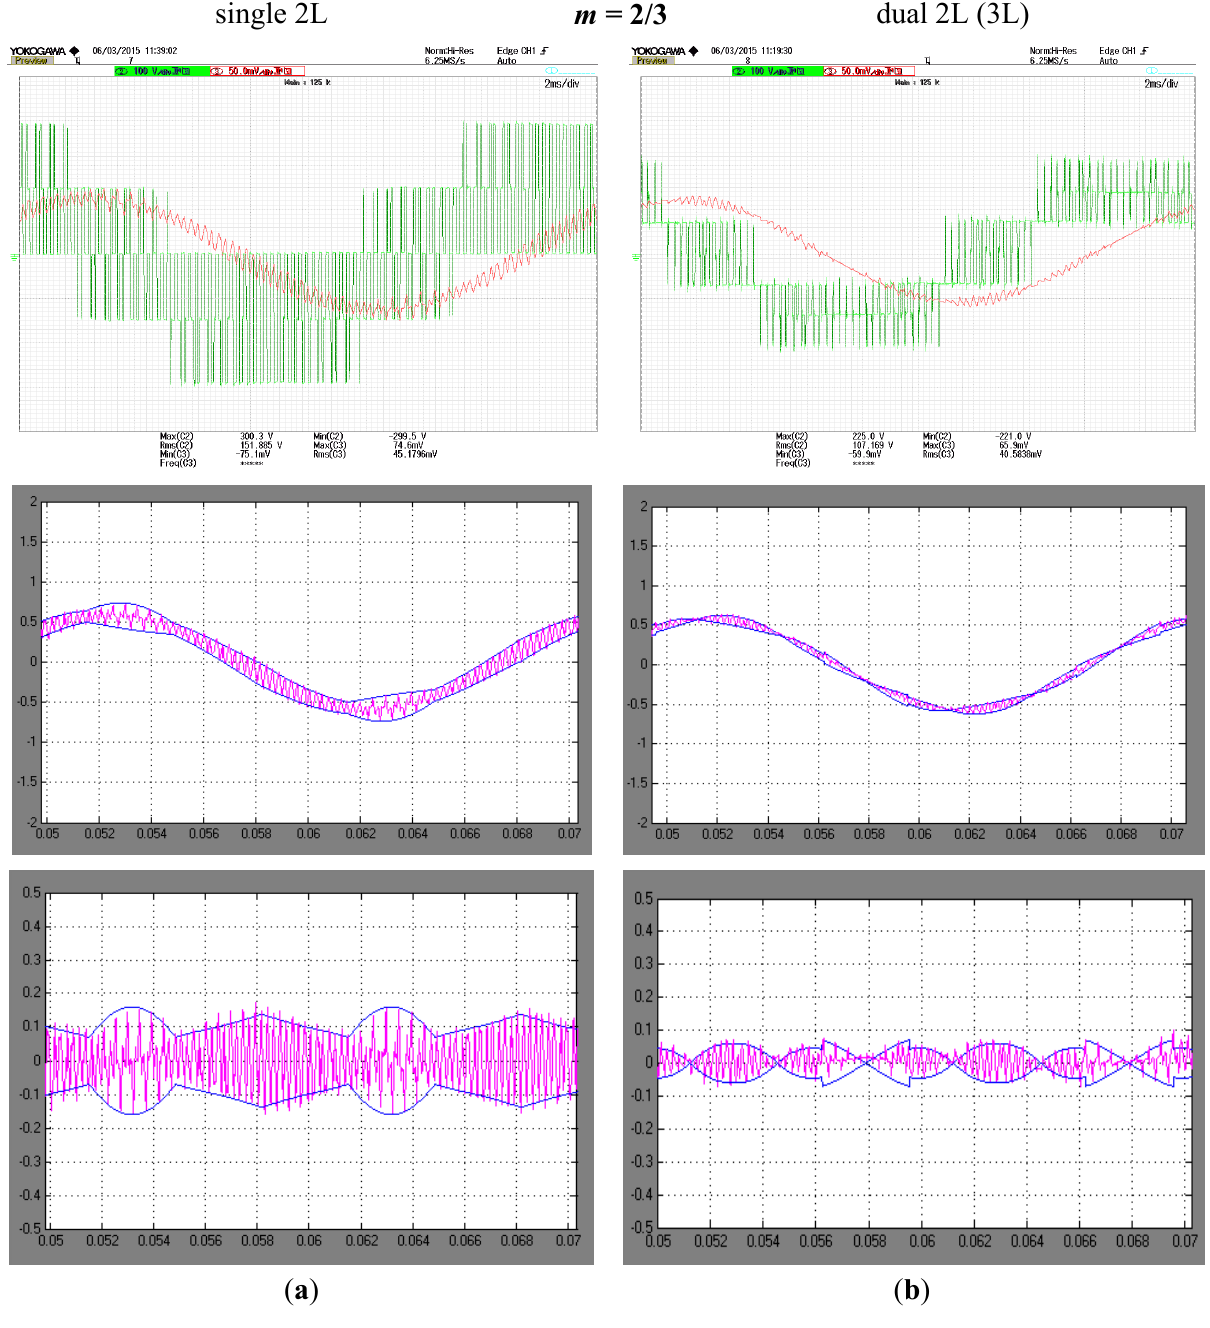
Figure 8. Experimental results: details of the output voltage and current waveforms from the oscilloscope, instantaneous output current with calculated peak-to-peak amplitude envelopes, and detail of current ripple with envelopes for m = 2/3: ( a ) single-2L inverter; ( b ) dual-2L (3L)